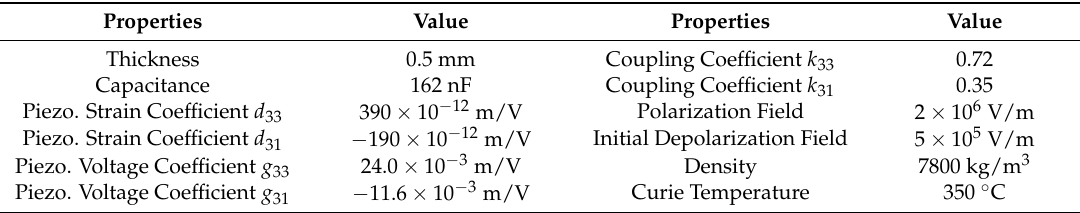
Figure 8. Bimorph concept: ( a ) parallel bimorph; and ( b ) serial bimorph. Table 1. Material properties of the piezoelectric ceramic patches ( PZT ) patch.